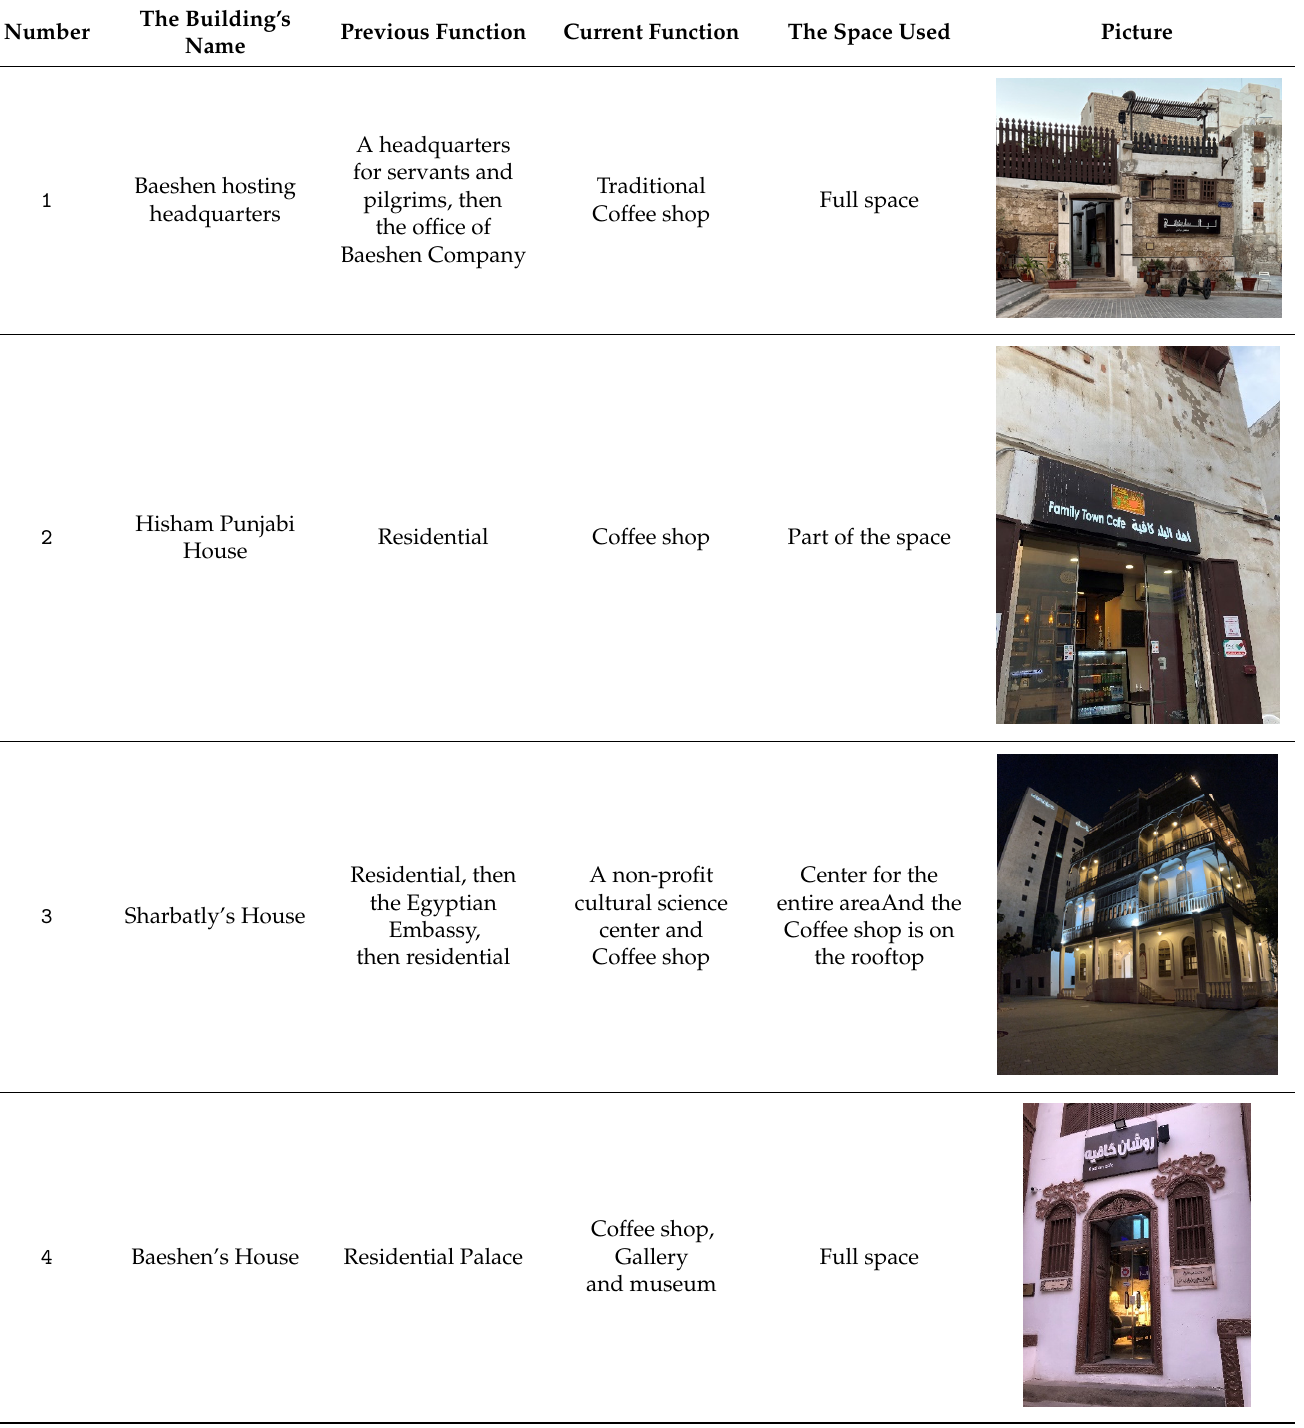
Figure 5. Matthew classification used in the historical area of Jeddah [16] .